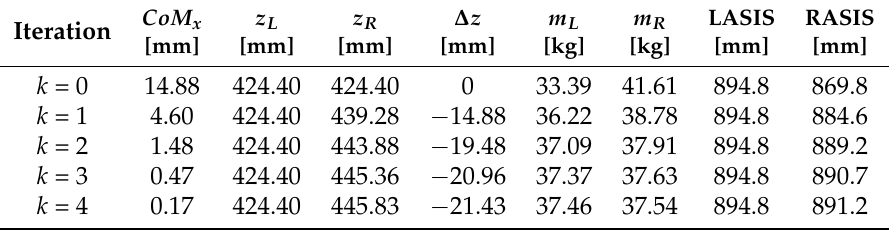
Table 2. Scenario 2: Figure 13 response values at the end of each iteration of the